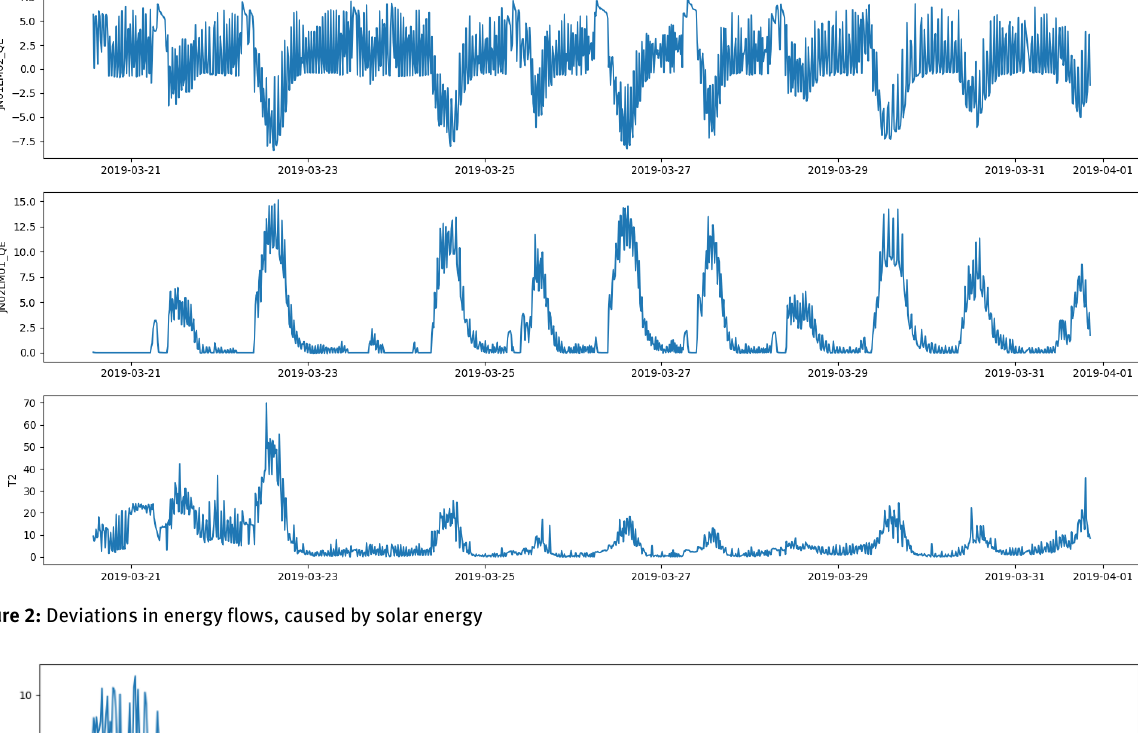
the anomaly was captured in terms of retained principal components, thus TS-PCA is able to interpret energy flows inside the system even with new disturbances added.